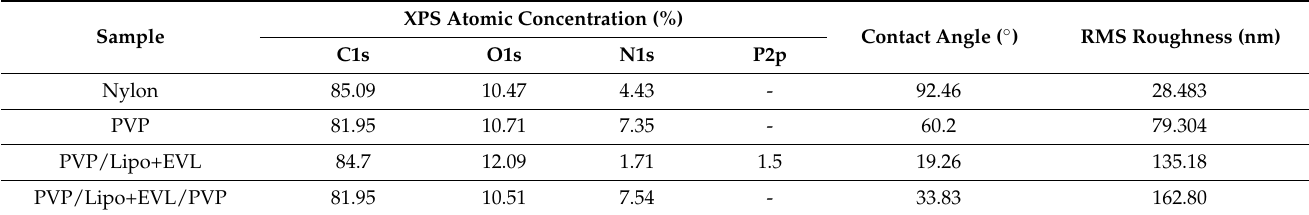
Figure 4. Characterization of PVP, PVP/Lipo + EVL, and PVP/Lipo + EVL/PVP-coated surface of Nylon tubes. ( A ) SEM images of the coated surface (Scale bars equal to 400 µ m). ( B ) Fluorescence images of the coated surface using FOBI. GreenL 5(6)-Carboxyfluorescein-stained PVP, Red: Nile red-labeled liposome. ( C ) AFM images for surface roughness evaluation. ( D ) ATR-FTIR analysis for Nylon tube surface coated with PVP, PVP/Lipo + EVL, and PVP/Lipo + PVP/PVP. ( a ) Bare Nylon tube, ( b ) PVP-coated Nylon tube, ( c ) PVP/Lipo + EVL-coated Nylon tube, and ( d ) PVP/Lipo + EVL/PVP-coated Nylon tube. Table 1. Summary of XPS atomic concentration, contact angle, and surface roughness from AFM for various treated Nylon